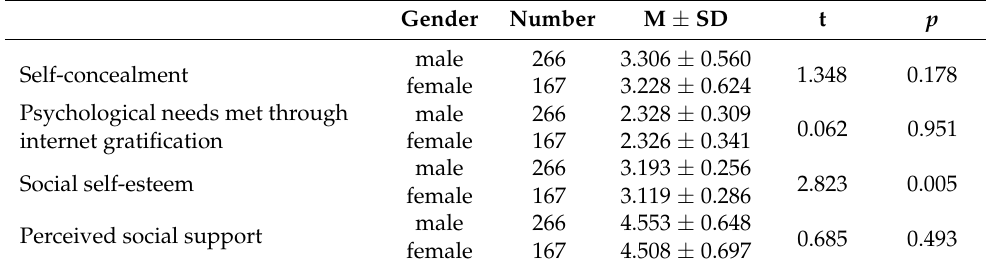
Table 1. Gender differences in all variables.